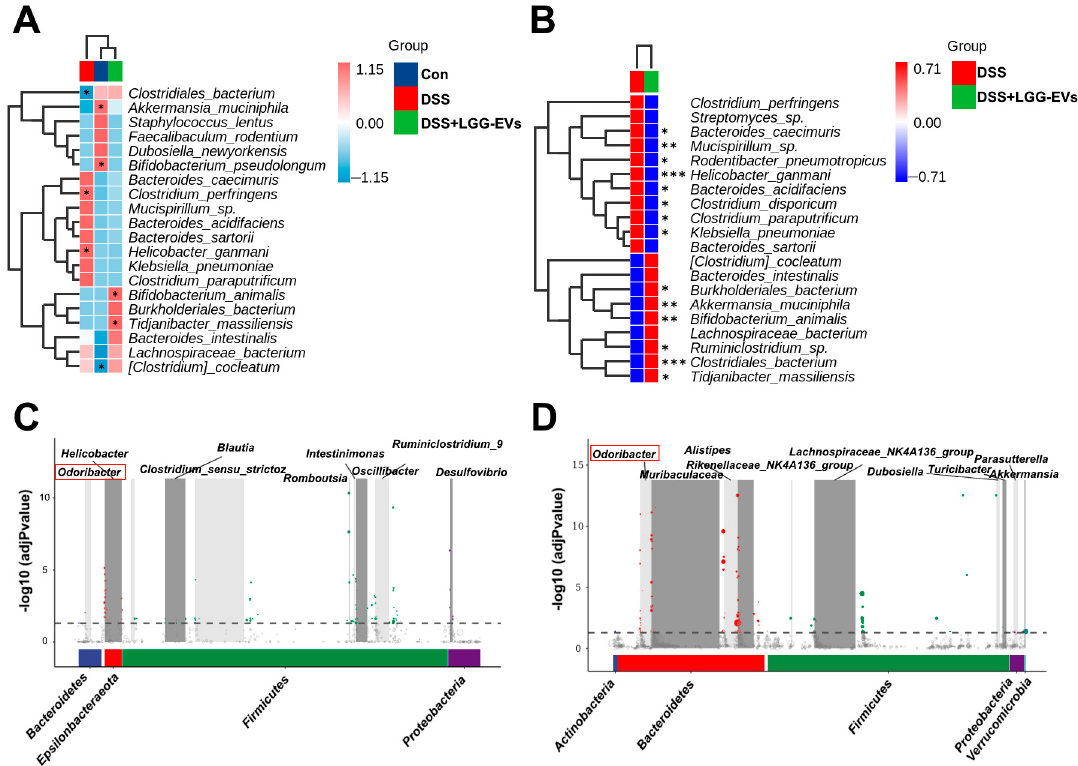
Figure 4. LGG-EVs reshaped the structure of gut microbiota in colitis mice. ( A ) Bar plots of the taxonomic composition at the phylum level. ( B ) The ratio of Firmicutes to Bacteroidetes in different groups. * p < 0.05, ** p < 0.01. ( C ) Bar plots of the taxonomic composition at the genus level. ( D ) Hierarchical clustering analysis based on unweighted UniFrac distance.